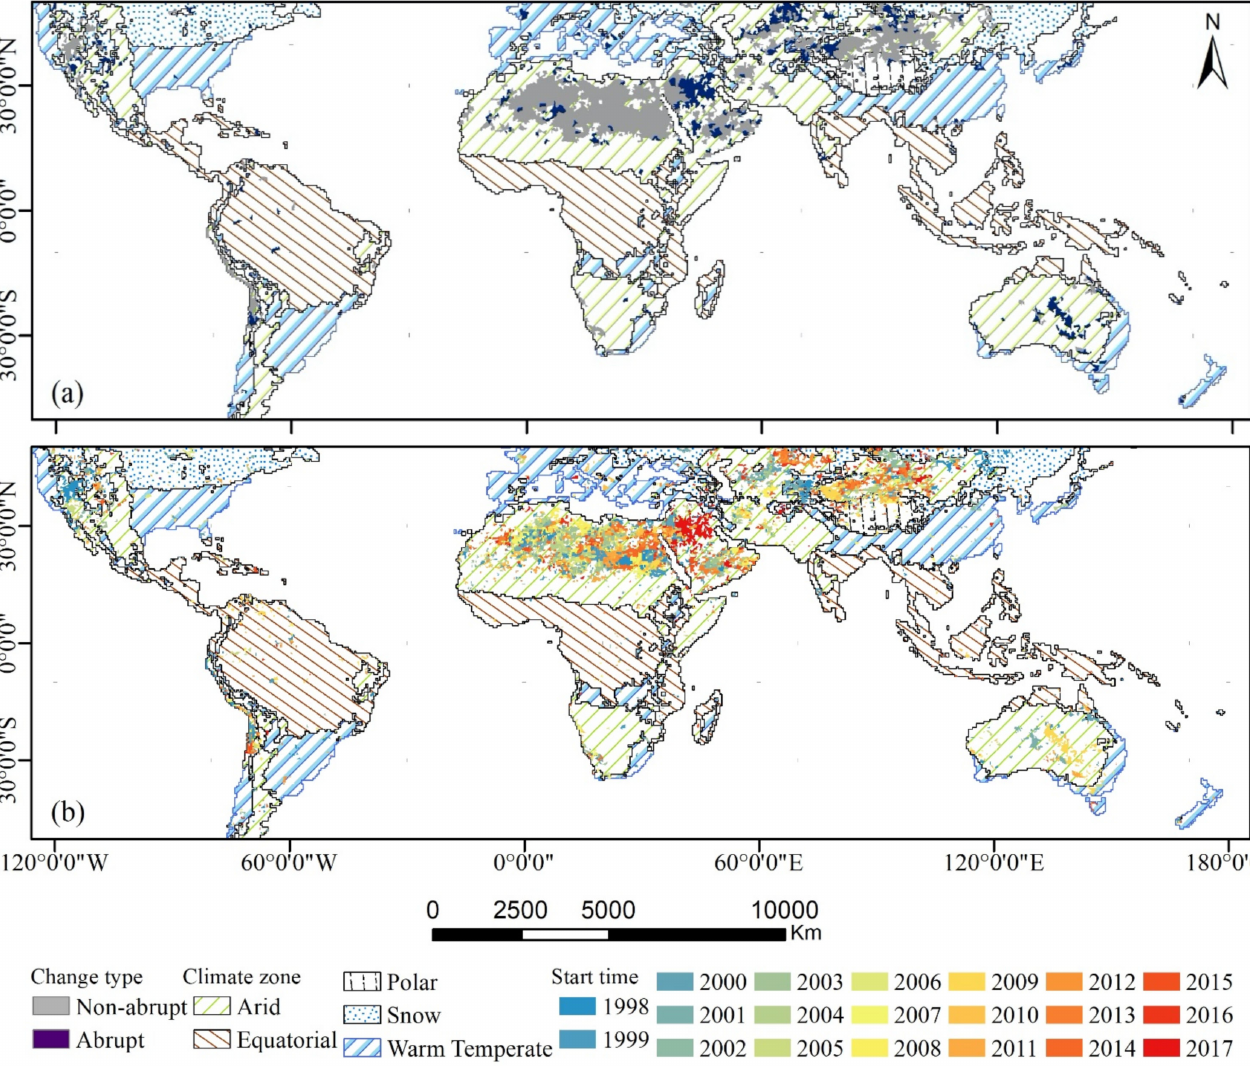
Figure 10. ( a ) Abrupt and non-abrupt changes at 0.05% significance level and ( b ) their start time, in different climate zones over the 1998–2019